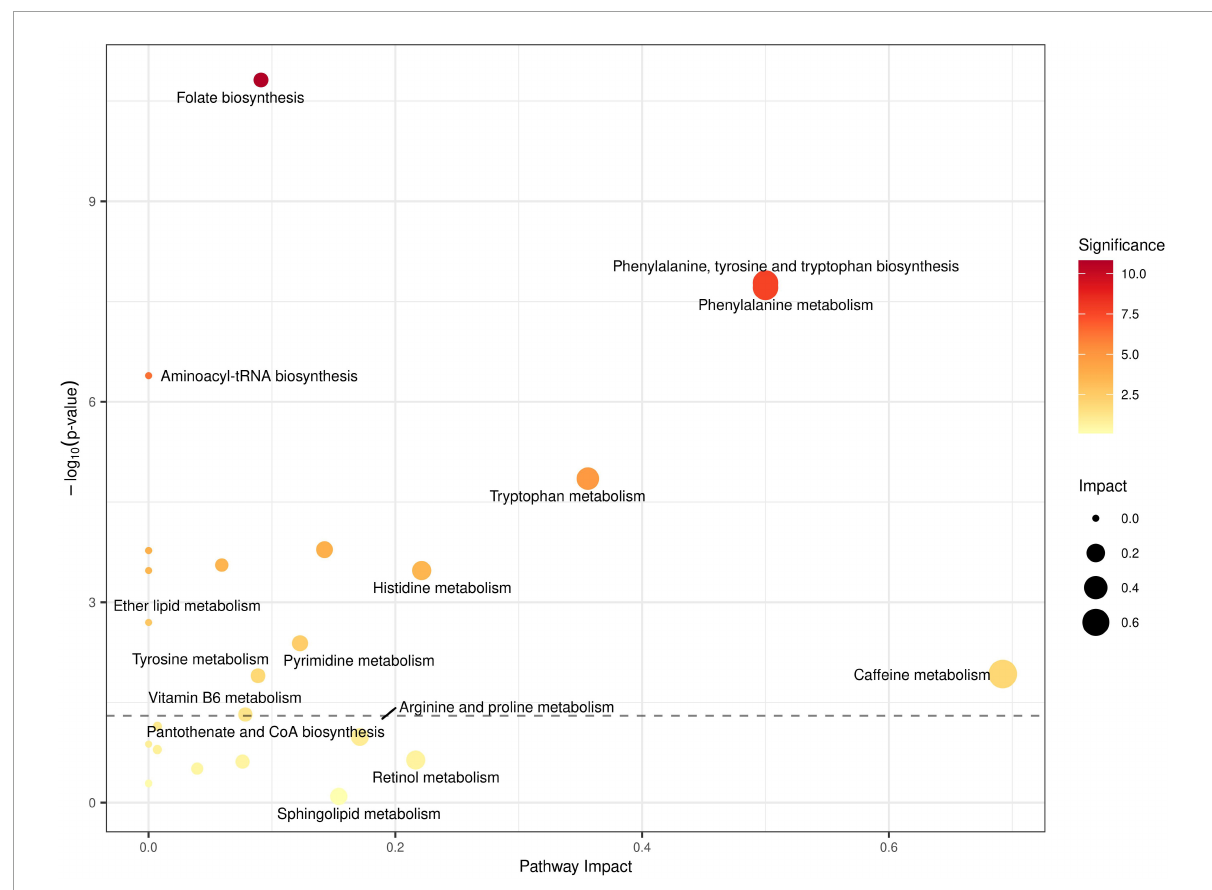
FIGURE4 Quantitative metabolic pathway enrichment analysis generated via MetaboAnalyst R (cid:13) , considering altered abundance profiles with respect to fasting status for all identified metabolites. Points represent metabolic pathways, color gradient and circle size represent enrichment significance (yellow: higher P -values and red: lower P -values) and pathway impact score (larger for higher impact score), respectively. x - and y - axes represent the pathway to impact and the negative logarithm of significance (higher implies smaller p -values), respectively, with the dashed line representing the significance threshold cut-off of P =